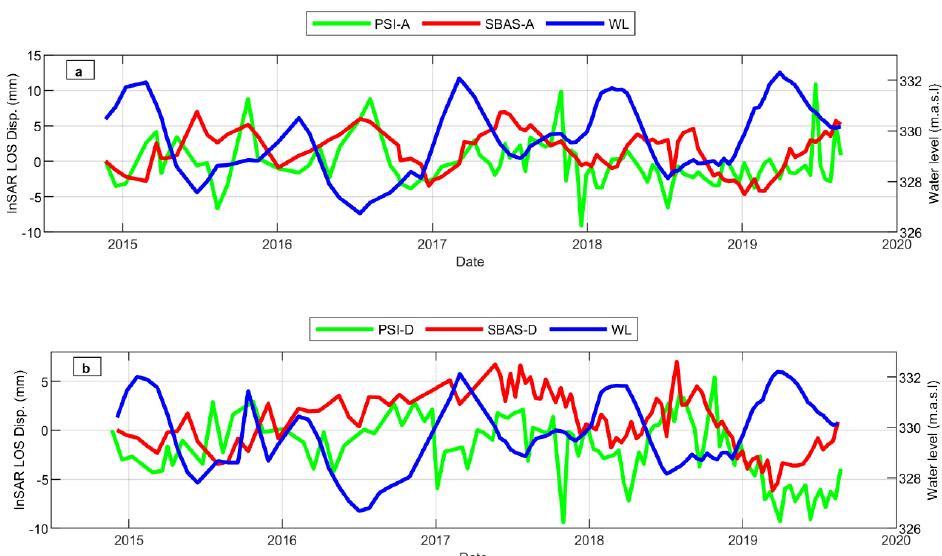
Figure 8. Displacements in the middle of the crest. Water level and PSI/SBAS ground displacement along the LOS at the middle of the crest (point b in Figure 7a). ( a ) The ascending mode and ( b ) the descending